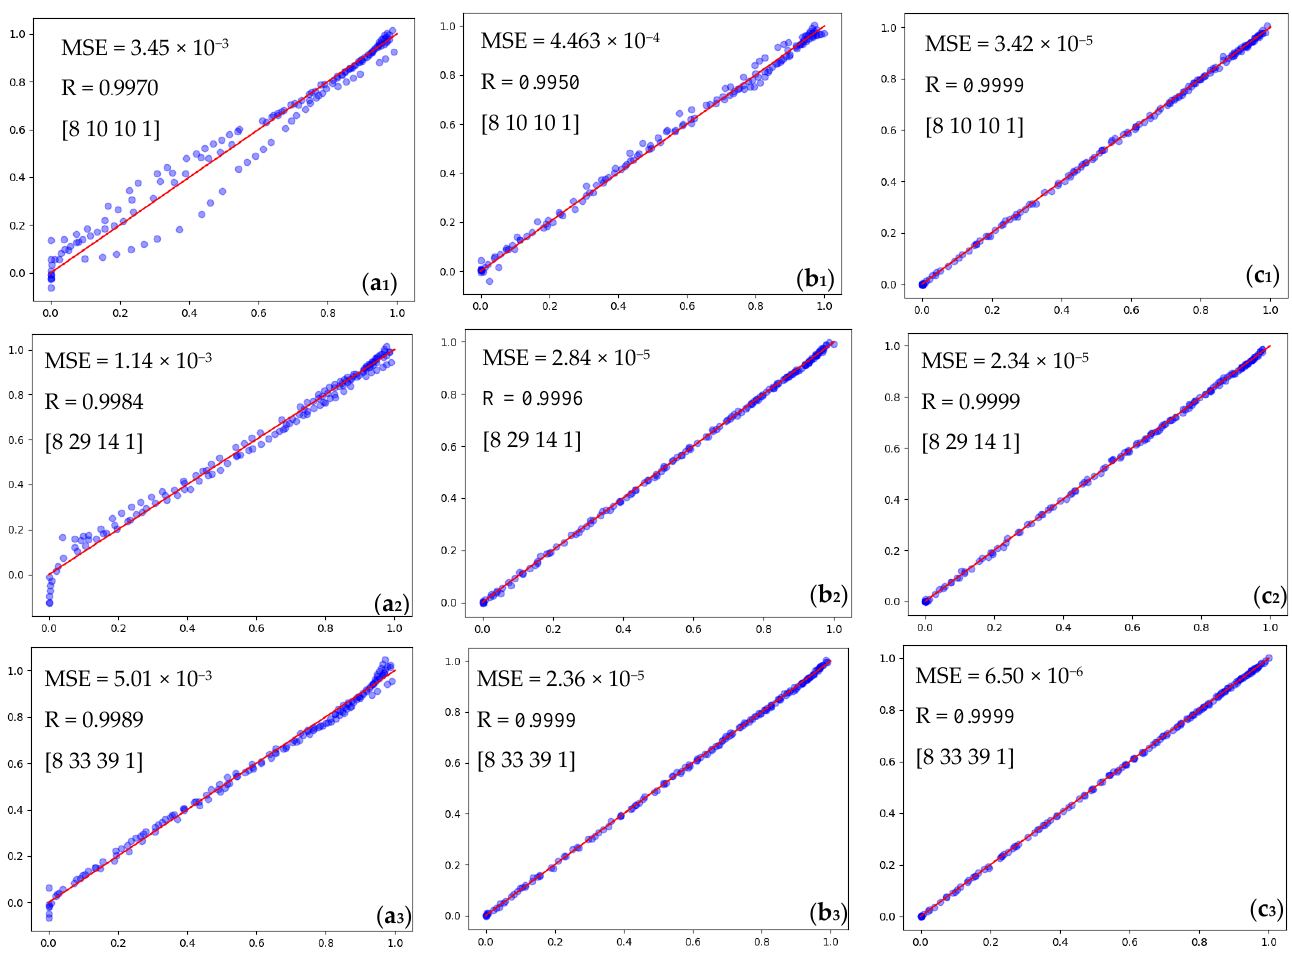
Figure 10. Comparison accuracy performance of MLP network using the Relu activation function. ( a 1 – a 3 ) SGD method, ( b 1 – b 3 ) Adam method, and ( c 1 – c 3 ) BFGS methods (blue dotes are data and the red line is the fit line).